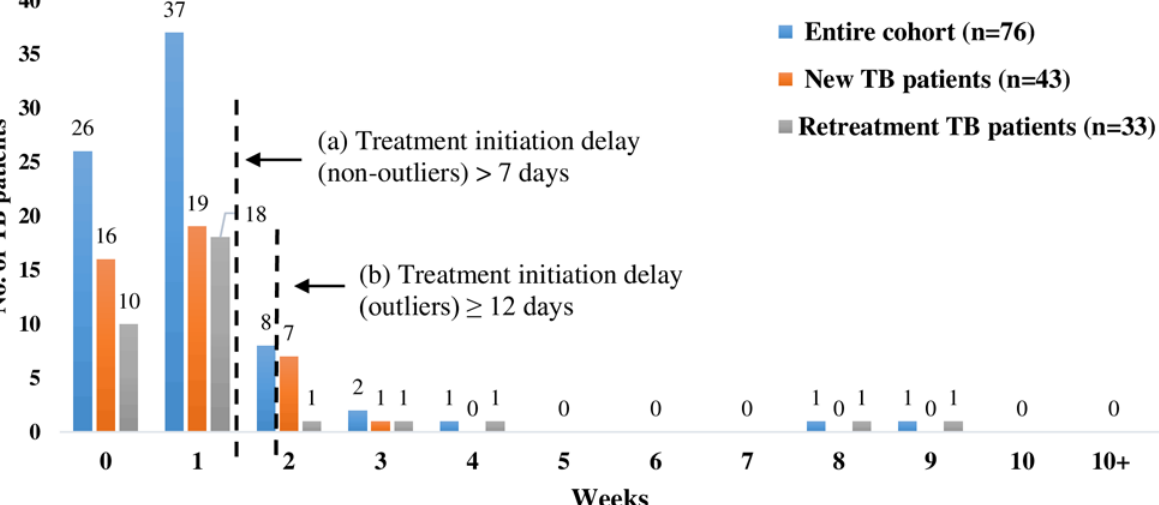
Fig 4. Initiation of Treatment: Duration and Delays. The figure represents the time taken from diagnosis of PTB to the initiation of anti-TB treatment. The serrated lines depict the durations that reflect (a) delay and (b) outliers.